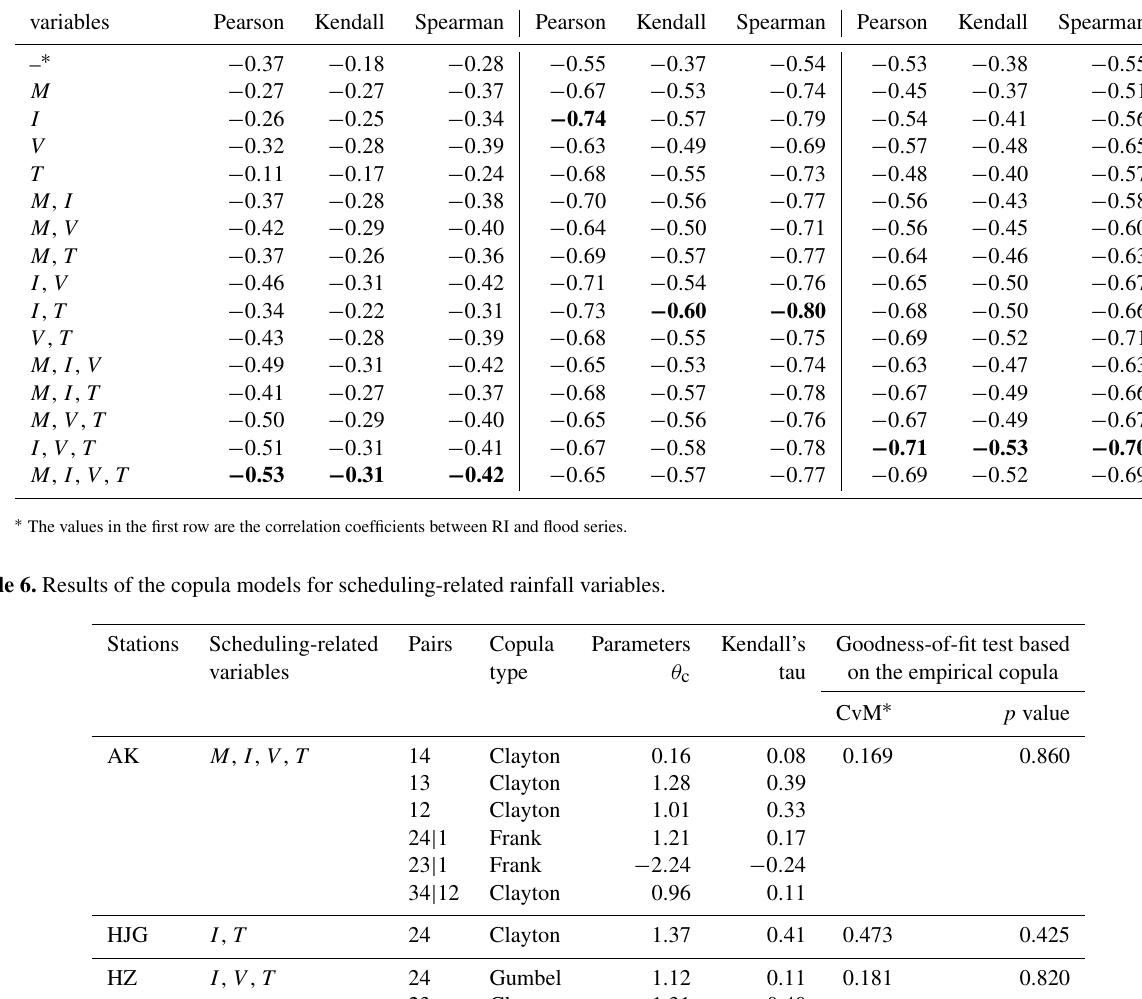
Table 5. Correlation coefficients between the RRCI and the AMDF. The values in bold font are the highest absolute values of Pearson, Kendall, or Spearman correlation coefficient for the station. Subset of rainfall AK variables Pearson